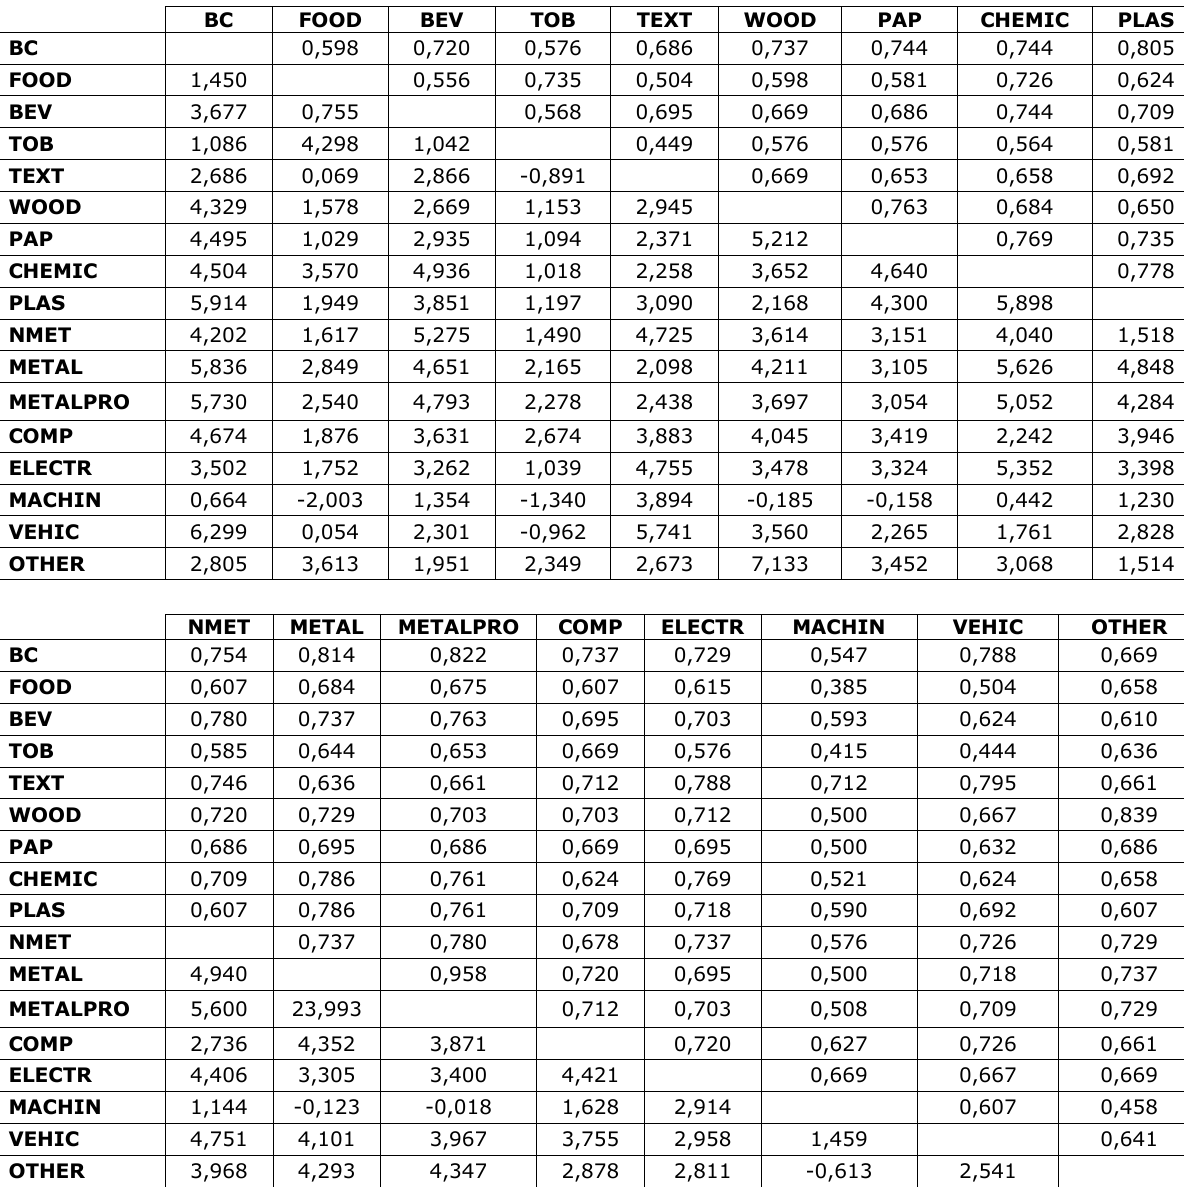
Table B.1. Concordance index (I) in the upper triangle and t-student in the lower